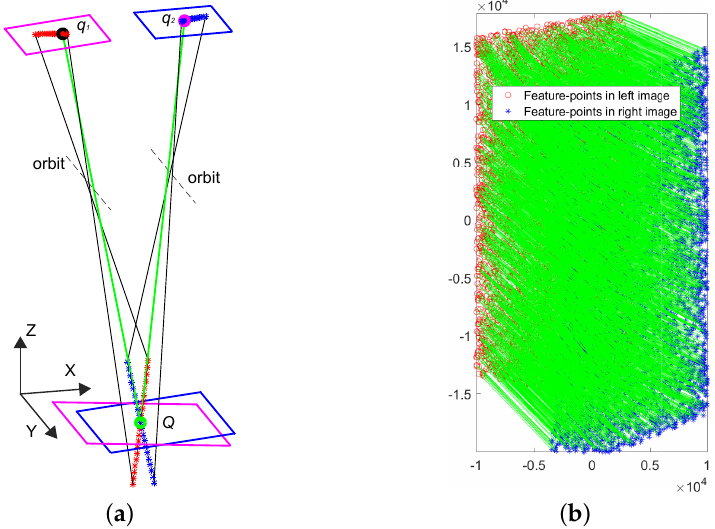
Figure 1. Pushbroom satellite stereo systems simulation. ( a ) An example of a cross-track linear pushbroom satellite stereo imaging system. ( b ) 5000 correspondences simulated by HiRISE imaging